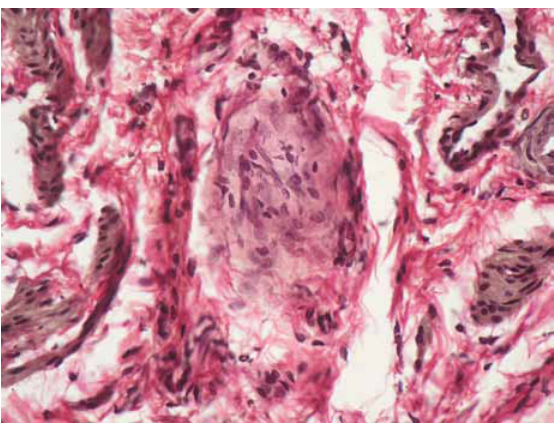
Figure 1. Photomicrography. Sites fibrinoid swelling with the formation of granulomas limphohistiocytes. Stained by Van Gisone. Increase